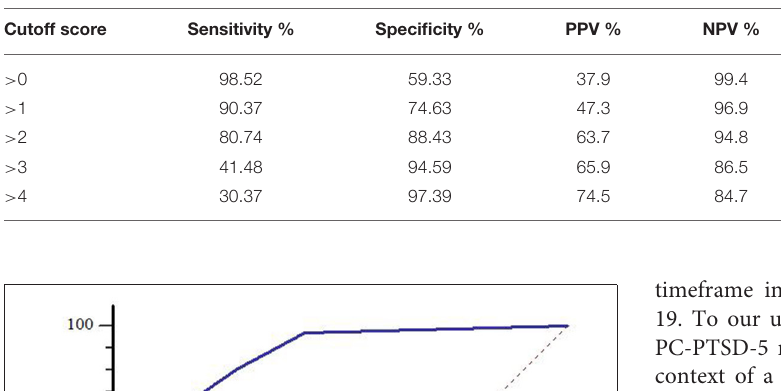
TABLE 5 | Operating characteristics of the PC-PTSD-5.